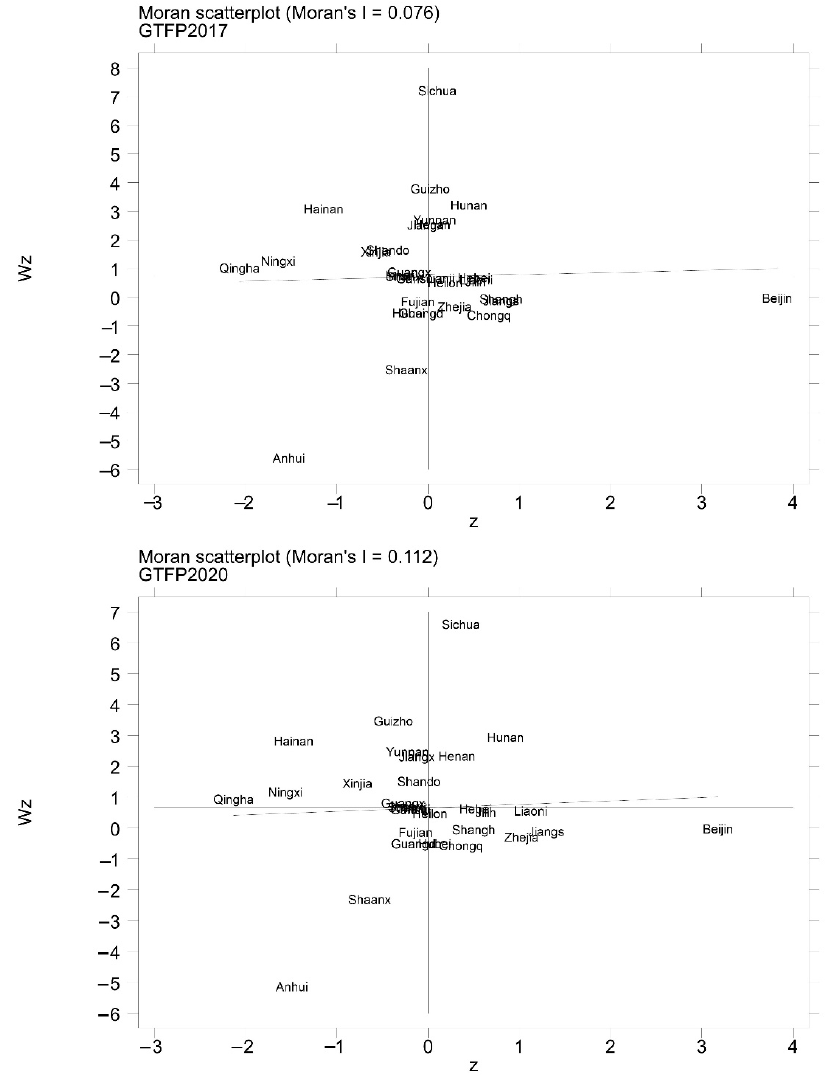
Figure 3. Moran scatter